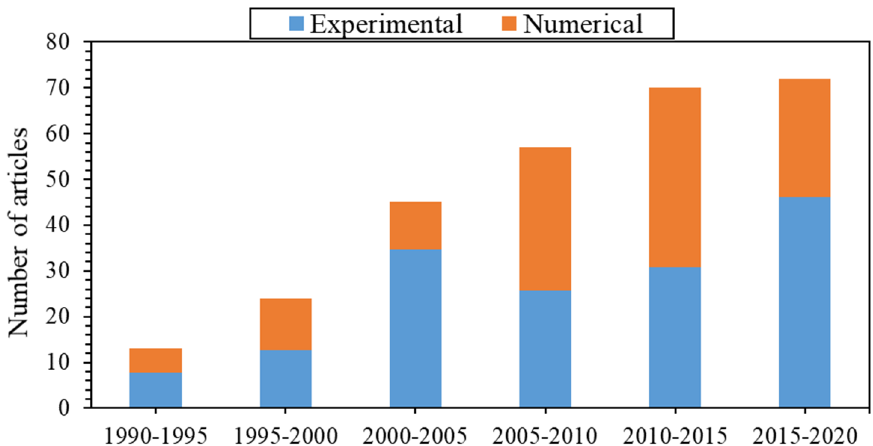
Figure 1. Experimental and numerical articles on straw bale construction between the years 1990 and 2020 [3].